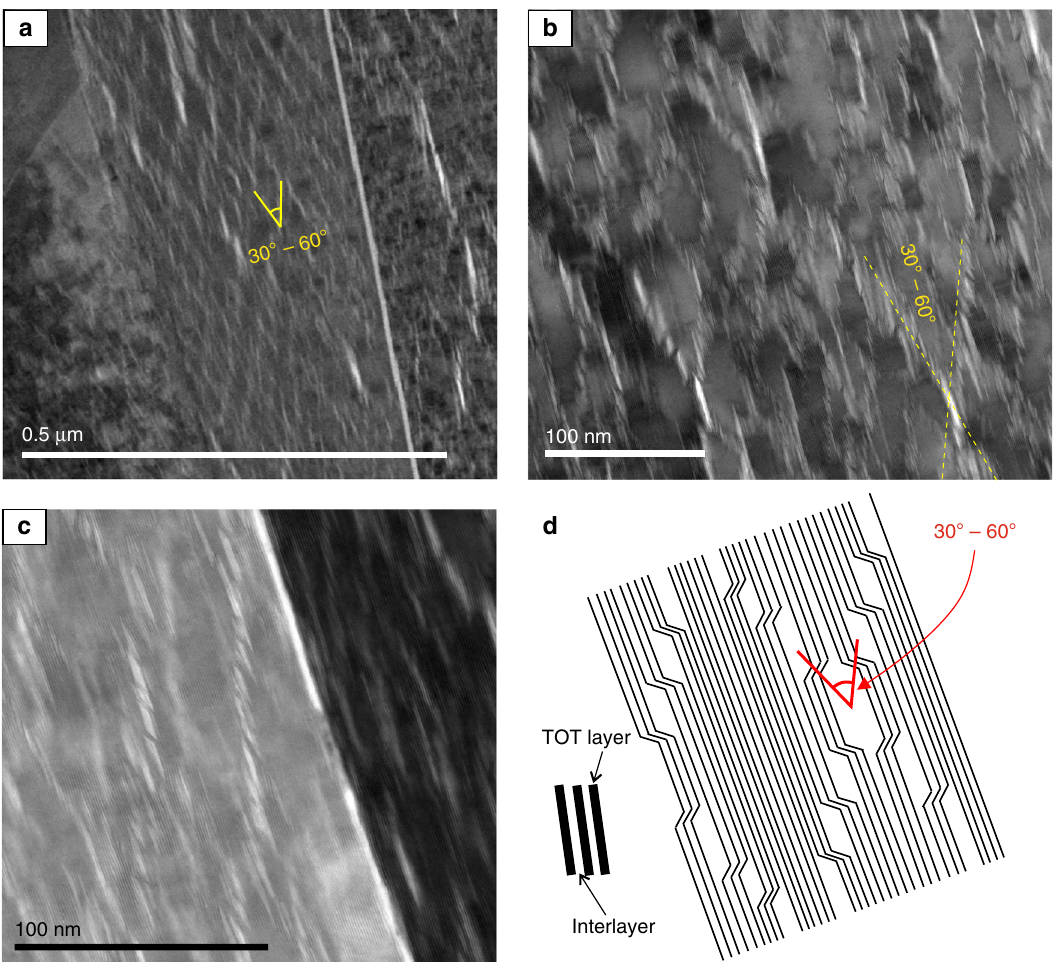
Fig. 2 Diamond-shaped expansion structure arrays. Bright fi eld transmission electron microscope micrographs of focussed ion beam-prepared biotite specimens from mylonitic orthogneiss. a Bright streaks parallel to the basal plane, but stacked in two principle orientations, produce elongated, diamond- shaped arrays across the entirety of biotite grains. The acute angles of these diamonds measure between 30° and 60°. b At higher magni fi cations, these streaks are revealed to be up to 60 Å wide, lozenge-shaped lattice expansion (or delamination) structures of the biotite basal planes. c Detail of expansion structures/delaminations stacked in en-echelon arrays. d Schematic of the features observed in a – c showing the en-echelon stacking of lozenge-shaped expansion structures/delaminations offsetting TMT layers and producing diamond-shaped